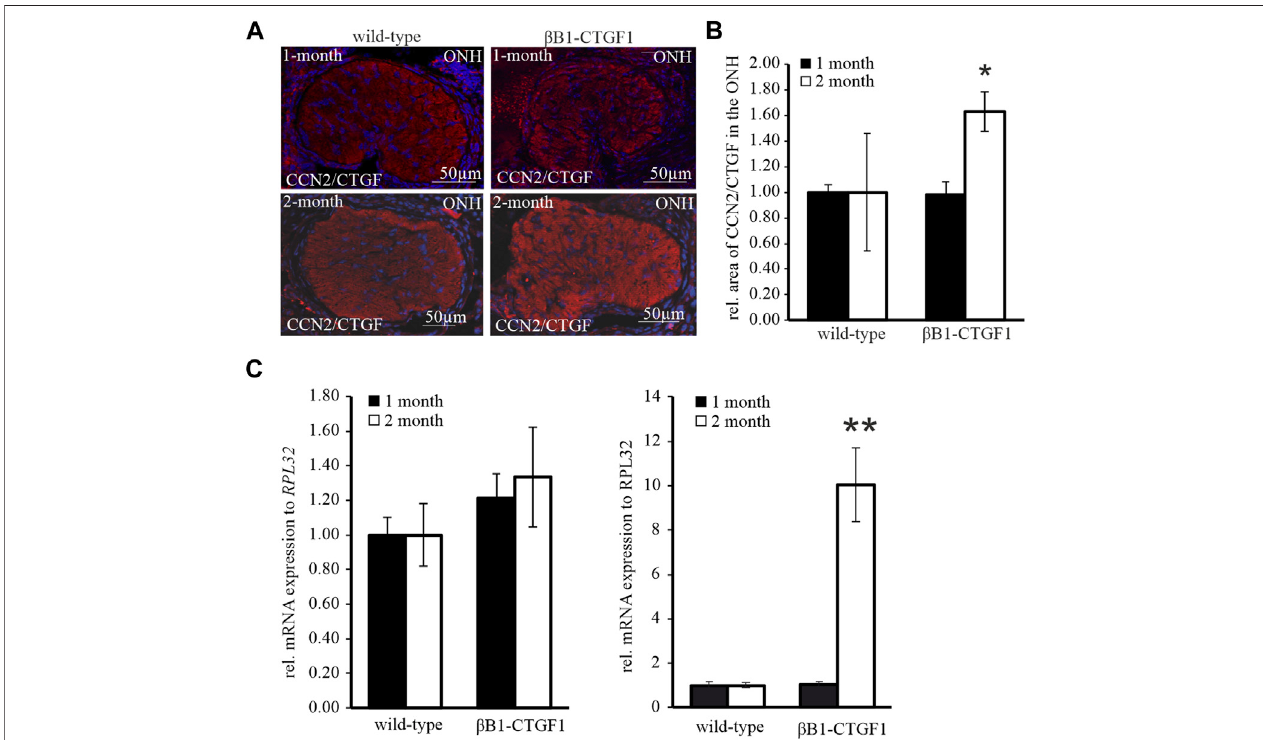
FIGURE 3 | CCN2/CTGF expression and protein synthesis in the ON and ONH in a murine glaucoma model. (A) CCN2/CTGF immunoreactivity (red) in the glial lamina of 1 month (upper panel) and 2 months (lower panel) old β B1-CTGF1 mice compared to WT controls. Immunoreactivity of CCN2/CTGF was not altered in 1- month old TG and WT animals (upper panel). 2 month old β B1-CTGF1 mice showed an increased CCN2/CTGF immunoreactivity compared to WT control (middle panel).NucleiarestainedwithDapi(blue). (B) Quanti fi cationofimmunohistochemicalstainingofCCN2/CTGFinthegliallaminaisnotalteredin1-montholdTGand WT animals (WT: n = 5; TG: n = 5). CCN2/CTGF immunoreactivity is increased in 2 month old TG animals compared to WT littermates (WT: n = 5; TG: n = 5; * p =0.028; unpairedtwo-tailed t -test). Meanvalue ofWT animals (control) wassetat 1. (C) RT-PCR analysesrevealedno alteration intheCCN2/CTGFmRNA expression intheON of1-month (WT: n =7;TG: n =4)and 2 month old β B1-CTGF1mice(WT: n =14;TG: n =16)comparedtoWT controls.IntheONH theCCN2/CTGFmRNAexpression is increased in the 2-month old TG compared to WT animals (WT: n = 6; TG: n = 5; ** p = 0.0006). The mRNA expression of CCN2/CTGF is not altered in 1-month old animals (WT: n = 6; TG: n = 3). Mean value of WT animals (control) was set at 1. RPL32 was used to normalize mRNA expression. Data represented as mean ± SEM. ONH, optic nerve